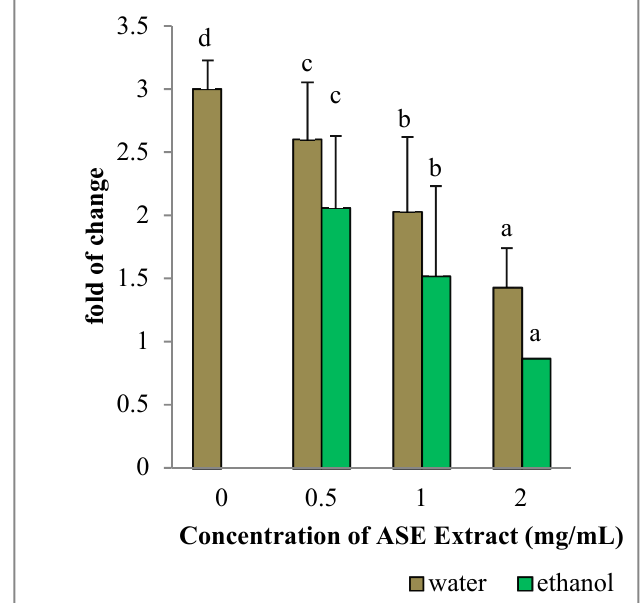
Figure 7. Effect of ASE crude extracts on Bcl-2 gene expression in MCF-7 cells. The mRNA levels are expressed as fold of change (2 − ∆∆ Ct ) as compared to untreated HepG2 cells (defined as 1) (mean ± SD; n = 6) and normalized to GAPDH. Bars marked by unlike letters within a group are significantly different at p < 0.05, according to Duncan’s Multiple Range Test (DMRT).